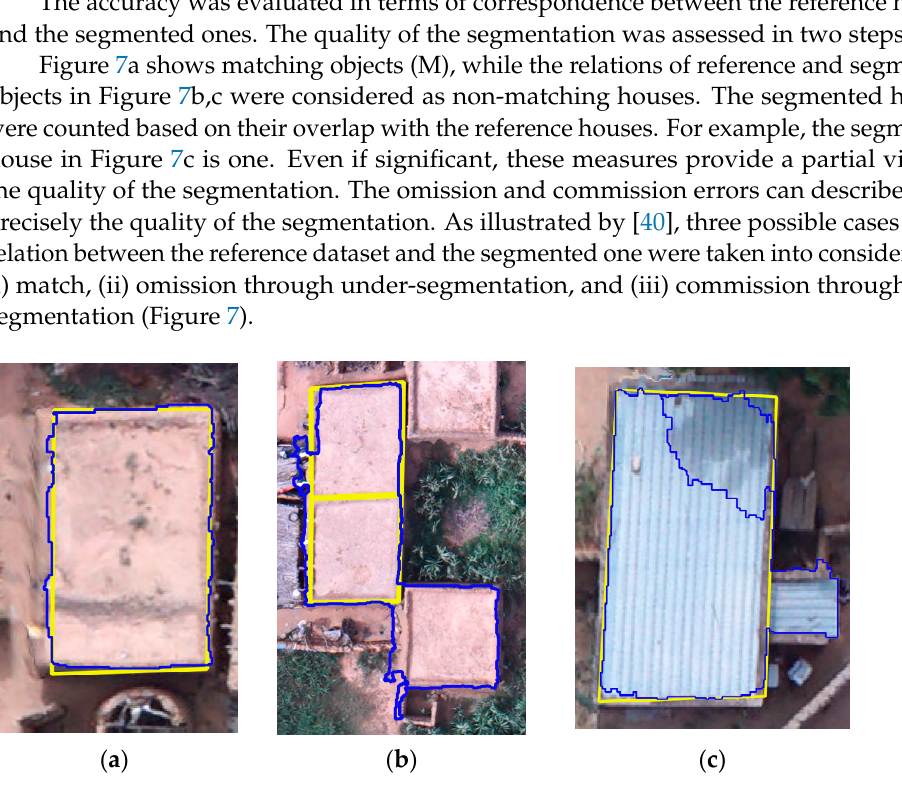
Figure 7. Possible relations between reference objects (yellow outline) and segmented objects (blue outline). ( a ) Match. ( b ) Omission through under ‐ segmentation. ( c ) Commission through over ‐ seg ‐ mentation.